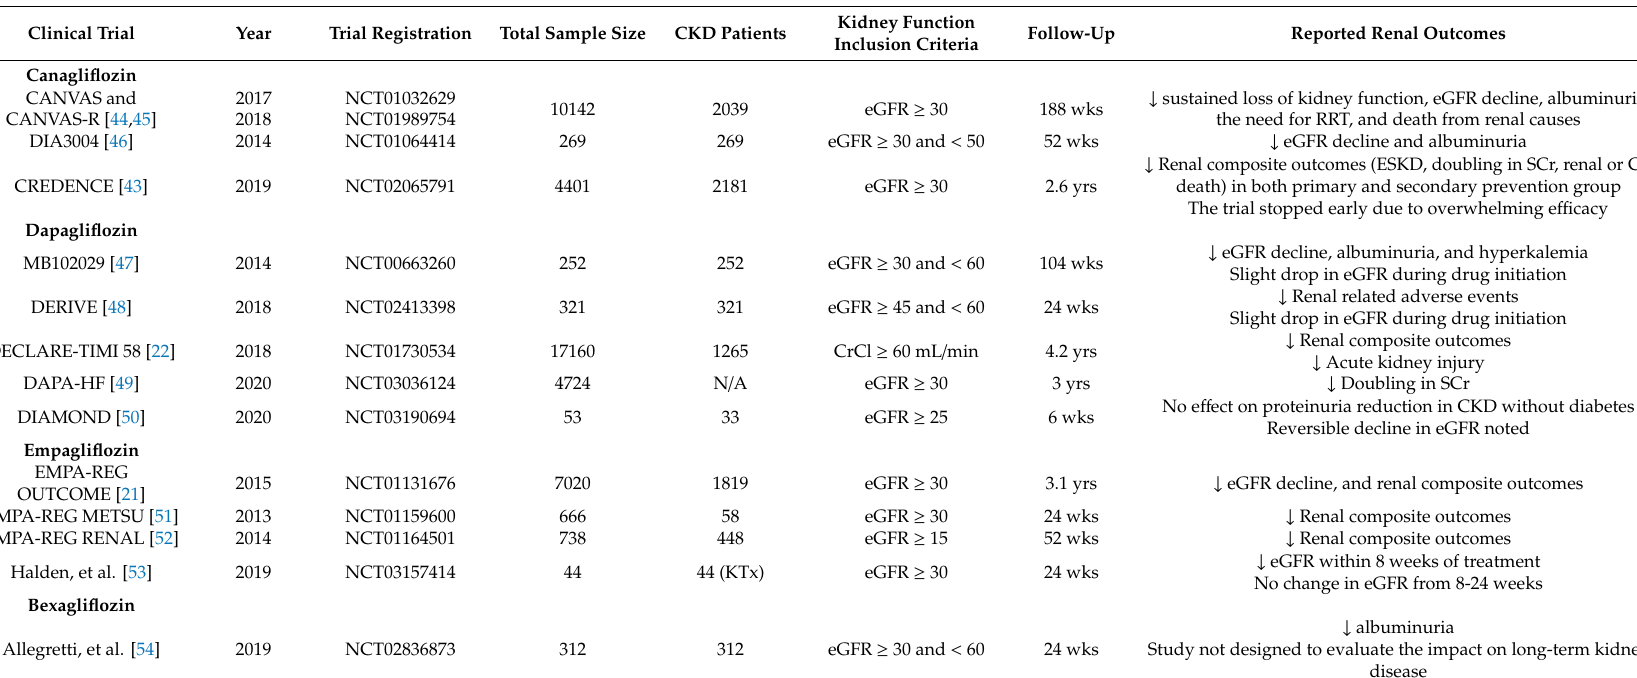
Table 1. Randomized placebo-controlled trials demonstrating the treatment outcomes of SGLT2 inhibitors vs. placebo in type 2 diabetes mellitus with